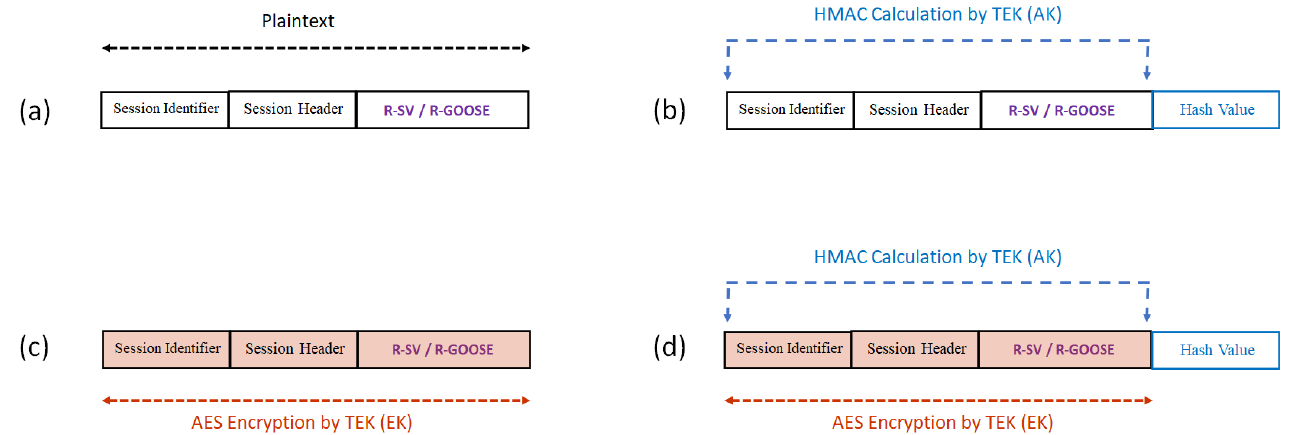
Figure 11. ( a ) None-secured R-SV/R-GOOSE, ( b ) Signed R-SV/R-GOOSE, ( c ) Encrypted R-SV/R- GOOSE, ( d ) Signed and Encrypted R-SV/R-GOOSE. GOOSE, ( d ) Signed and Encrypted